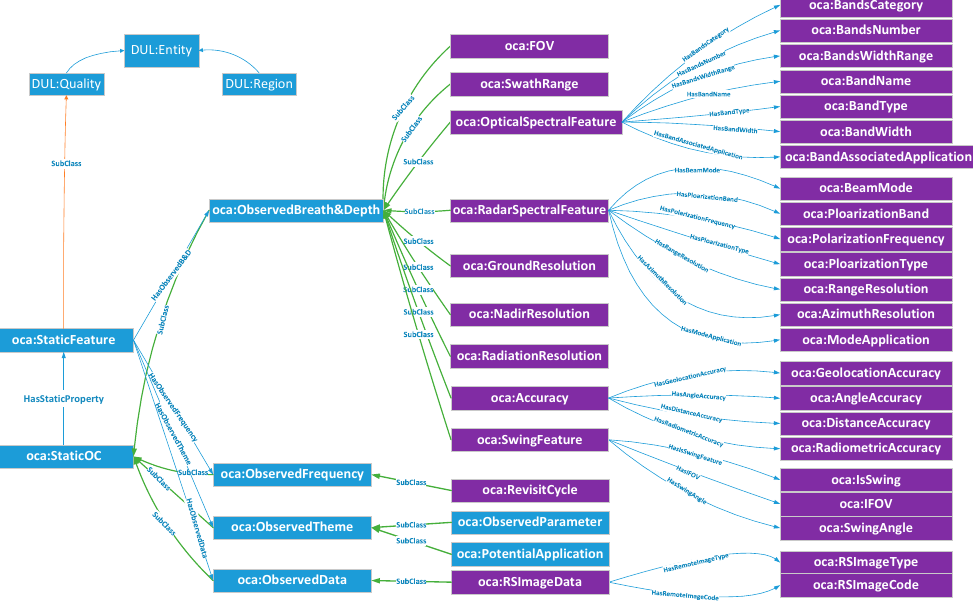
Figure 5. Core classes of remote sensing sensor StaticOC module.